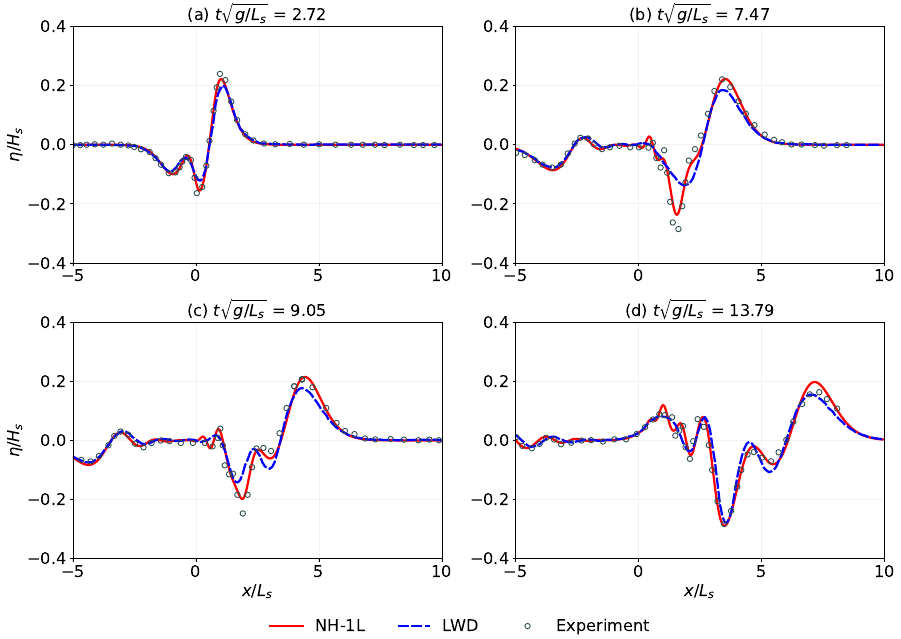
Figure 11. Comparisons of observed and predicted wave heights at several times in run 23.